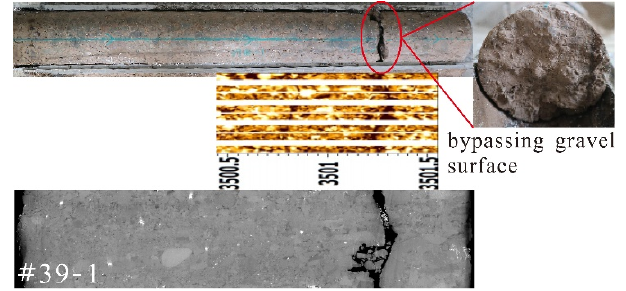
Figure 3. Features of a tensile fracture.